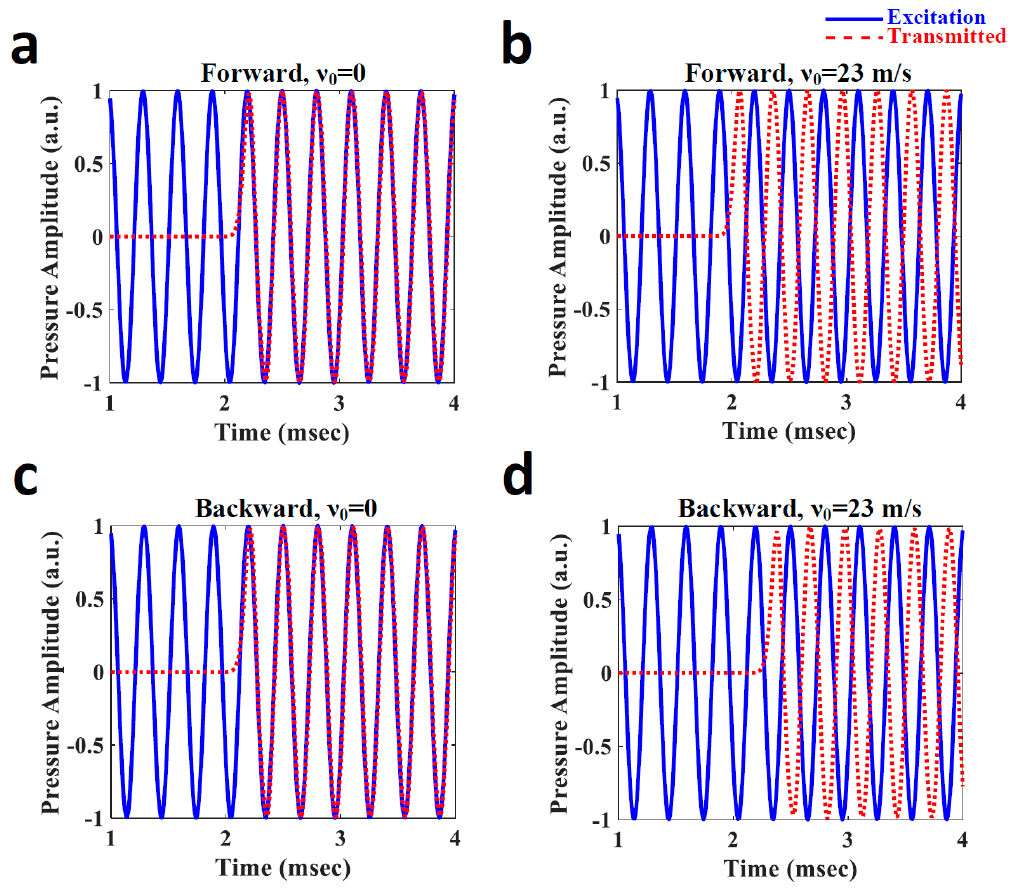
Figure 3. Demonstration of the proposed non-reciprocal acoustic phase shifter. ( a ) An excitation pulse (the solid blue line) is considered to be injected to the left side of the waveguide of Figure 1b. The signal that is received at the other side (the red dashed line) is in phase with the excitation when ν 0 = 0. ( b ) Same as panel a, except that a bias velocity of ν 0 = 23 m/s, which corresponds to the phase shift of ϕ 1 = π , is imparted on the fluid. The transmitted signal is now led by 180 degrees with respect to the excitation. ( c , d ) The same process has been followed when the waveguide is excited from the right side. In the case of the stationary fluid (panel c), the time evolution of the transmitted signal is exactly identical to that of panel a, stemming from the reciprocity of the structure. When assuming ν 0 = 23 m/s, however, the received signal is lagged (not led) by 180 degrees with respect to the input field, manifesting the non-reciprocity of the structure in